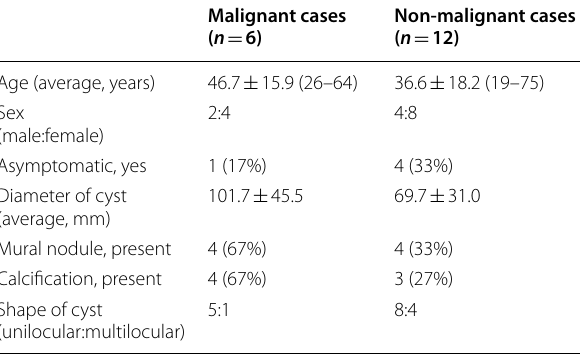
Continuous date are shown as the mean to maximum)